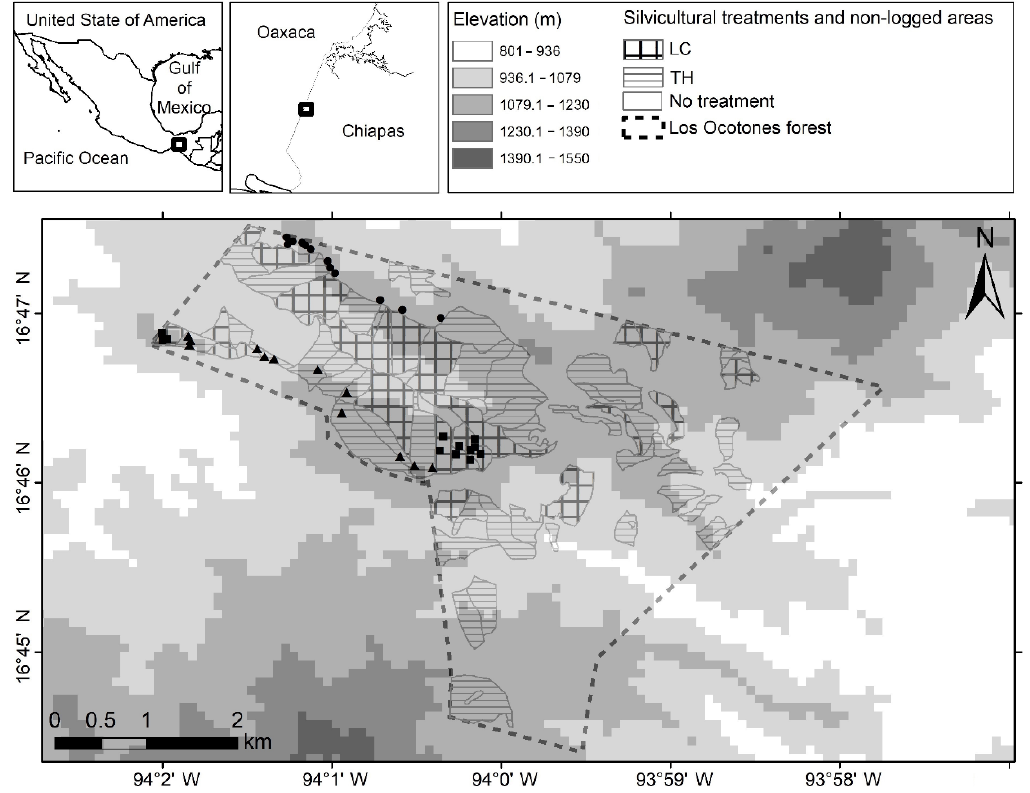
Figure 1. Location of the Ocotones forest in Chiapas, Mexico, and the sampling sites (Triangle: thinning treatment, square: liberation cut treatment, circle: no treatment).